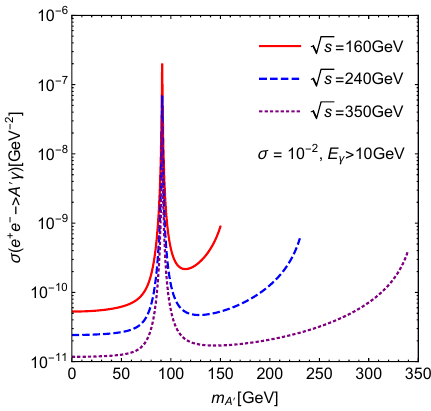
p s = 160 GeV, 240 GeV and 350 GeV with (cid:27) = 10 (cid:0) 2